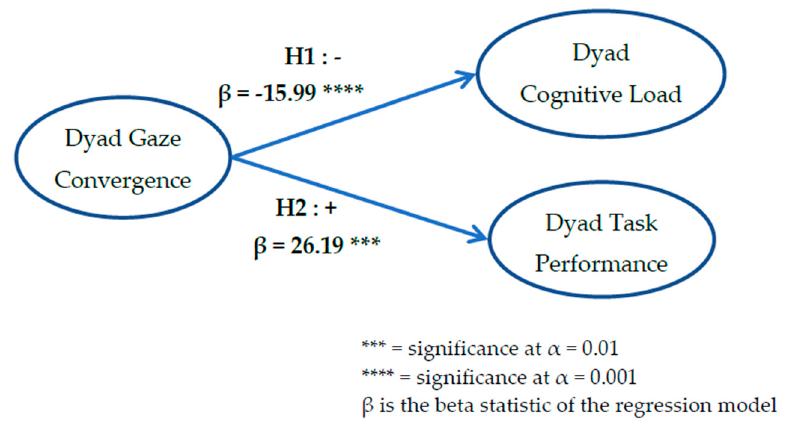
Figure 6. Results, Study 2.